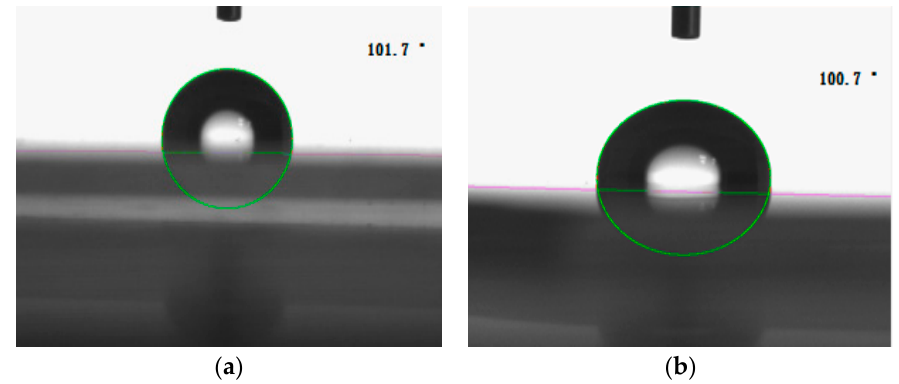
Figure 8. Hydrophobicity of the nanocompostie film. ( a ) Ternary SiO 2 –Al 2 O 3 –TiO 2 nanoparticles; and ( b ) SiO 2 nanoparticles.